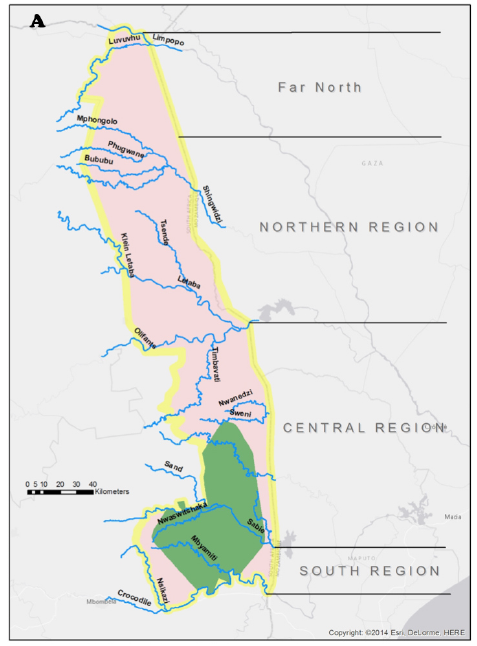
Figure 1. KNP and location of the study area (green